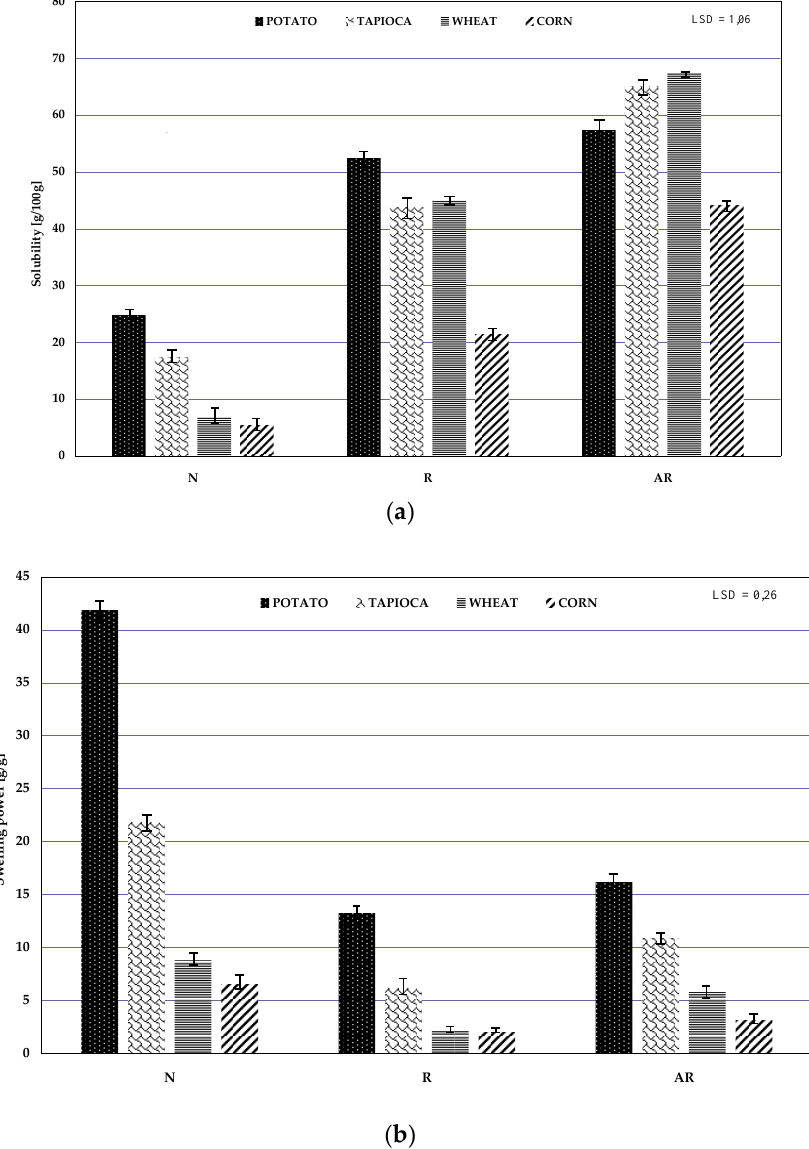
Figure 3. Solubility ( a ) and swelling power ( b ) of native (N), retrograded ®, and acetylated retrograded (AR) starch of various botanical origin.